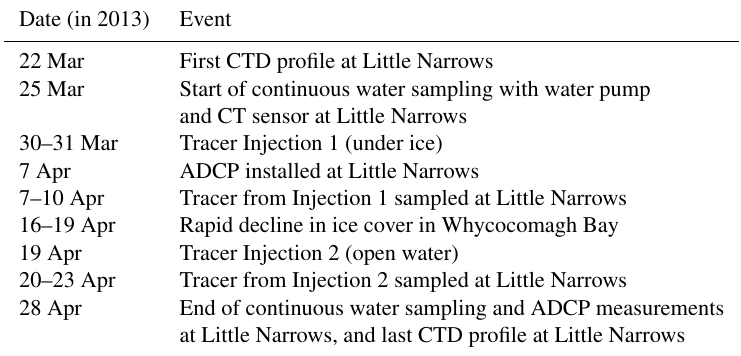
Table 1. Key events during